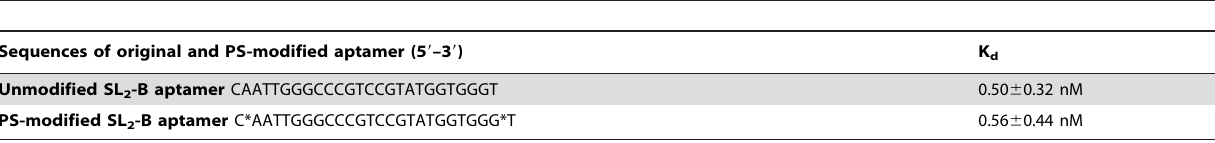
Table 1. Unmodified and PS-modified SL 2 -B aptamer sequences along with their equilibrium dissociation constant (K d ) values determined using surface plasmon resonance (SPR)